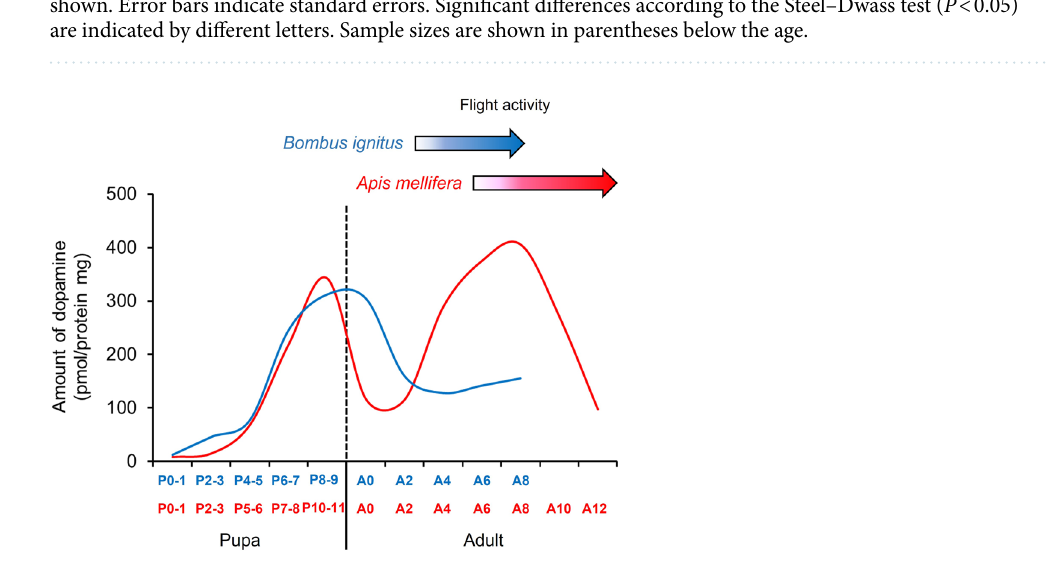
Figure 8. Comparison of changes in dopamine levels in the brains of honey bee and bumble bee males. Red and blue lines indicate dopamine levels in the honey bee ( Apis mellifera ) and bumble bee ( Bombus ignitus ), respectively. Dopamine data for the honey bee were obtained in the present study and studies by Harano et al. 22 and Watanabe and Sasaki 32